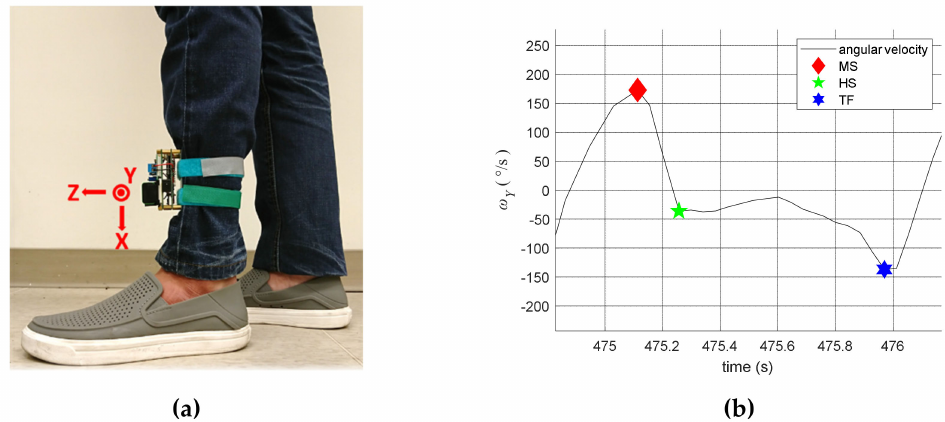
Figure 4. Gait measurement. ( a ) The IMU attachment; ( b ) the angular